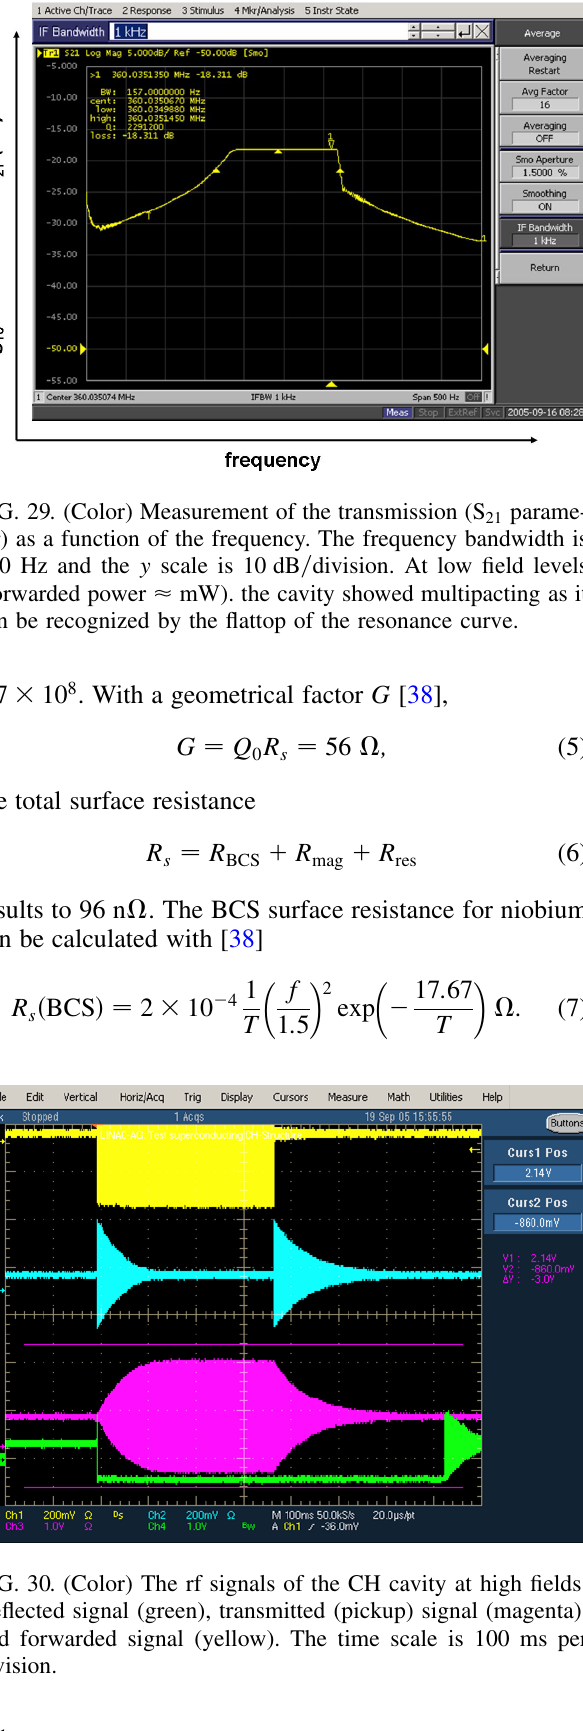
cavity in a closed loop.